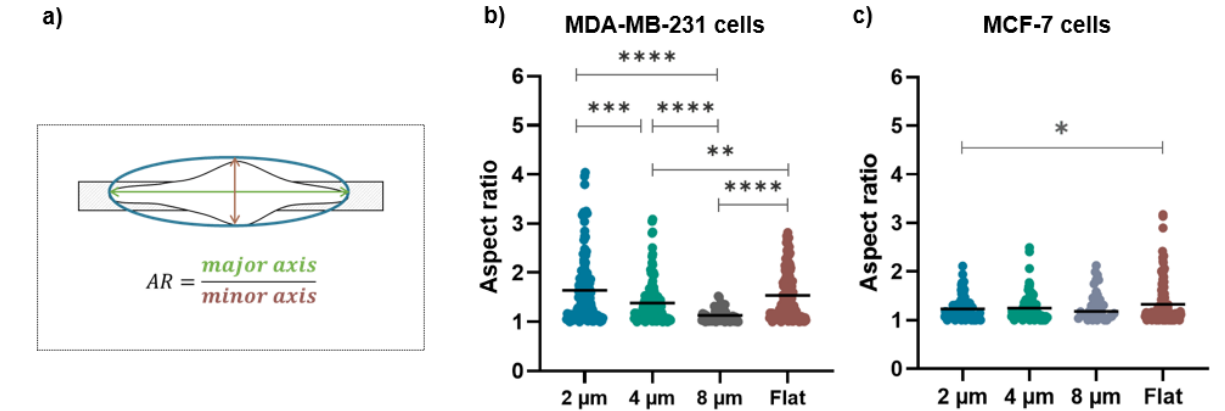
Figure 6. ( a ) The schematic representation of the long and short axes of cells on structures with different gap sizes used to evaluate the aspect ratio (AR); ( b ) aspect ratio values for MDA-MB-231 cells on 2 µ m (n = 146), 4 µ m (n = 132), and 8 µ m (n = 61) wide micro-gaps and on flat membranes (n = 150); ( c ) aspect ratio values for MCF-7 cells on 2 µ m (n = 108), 4 µ m (n = 94), and 8 µ m (n = 34) wide micro-gaps and on flat membranes (n = 149). The black line is the mean value for each data set. For the MDA-MB-231 cells grown on 2, 4, and 8 µ m wide gaps, we obtained mean angle values of (2.8 ± 2.1) ◦ , (3.5 ± 2.5) ◦ , and (3.1 ± 2.7) ◦ , respectively (Figure 5b).